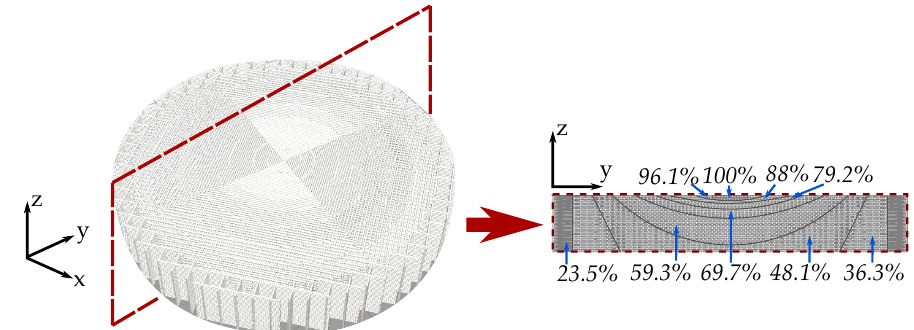
Figure 6. Transformed hyperbolic lens printed with one filament of ε r = 12 and the corresponding infill percentages for each permittivity